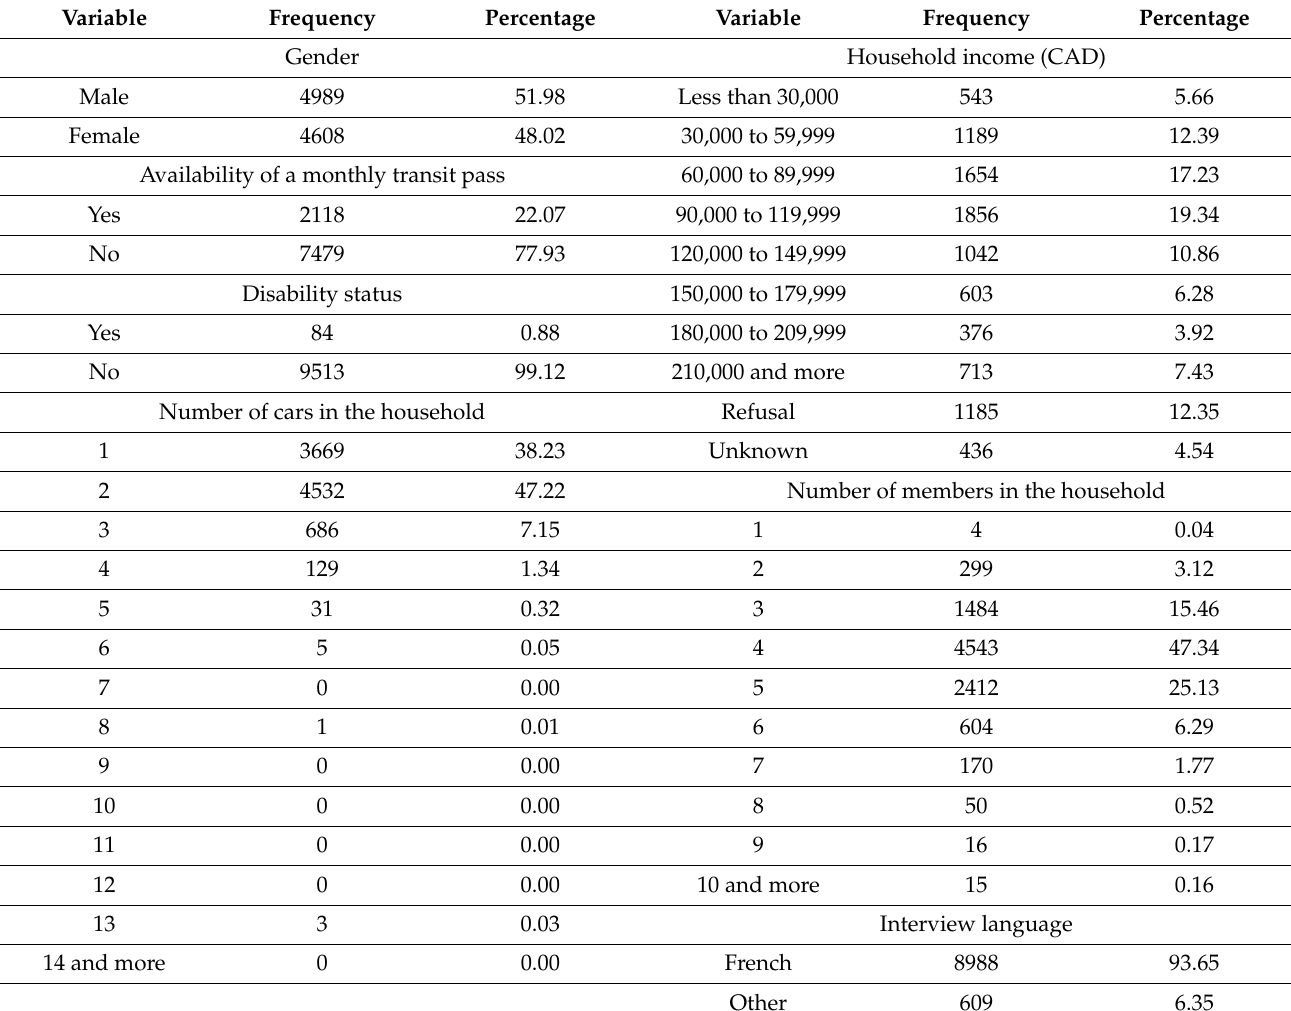
Table 2. Attribute of selected